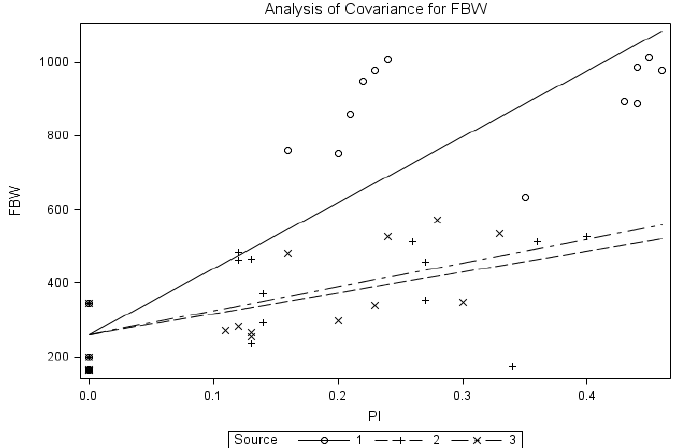
Figure 1. Common-intercept, multiple-linear regression of final body weight (FBW; g) on supplemental P intake of chicks fed diets supplemented with P from monosodium phosphate (MSP; Source 1), brown-seeded pea (BP; Source 2), and Yellow-seeded pea (YP; Source 3). The circular marker represents MSP, the plus marker represents BP, and the multiplication marker represents YB. The common-intercept, multiple-linear regression equation (mean±standard error) was Y = 259.35±31.58+1,793.75±148.25MSP+ 565.22±202.67BP+649.30±238.83YP, R2 = 0.77, p<0.0001; the relative bioavailabilities estimated by slope-ratio were 31.5% and 36.2% for BP and YP,